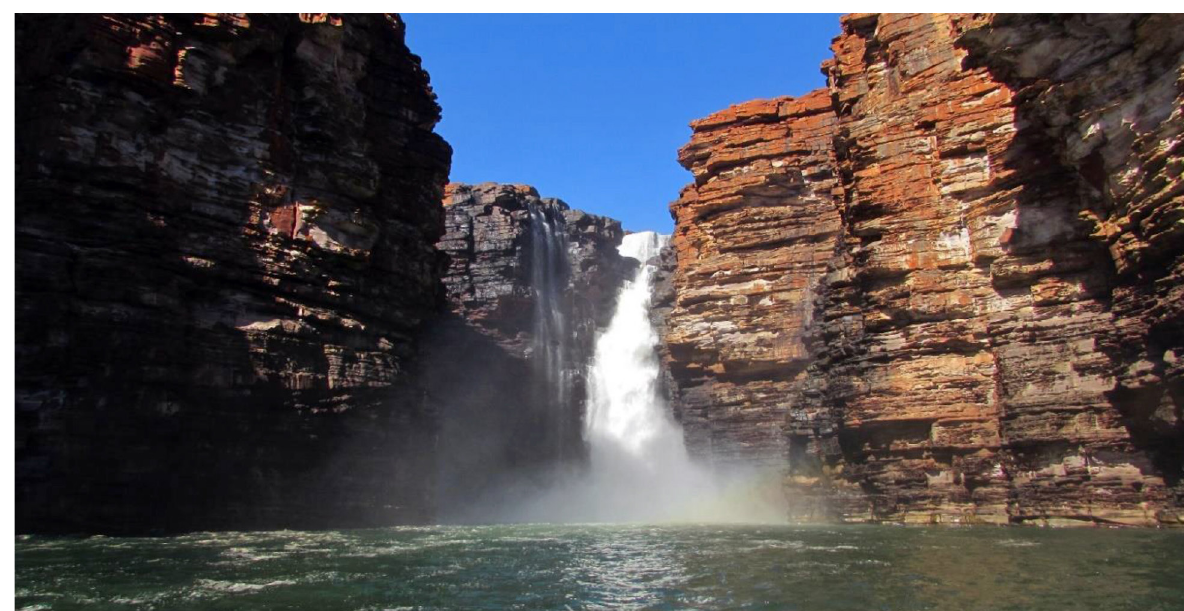
Fig. 5. The King George Falls, Kimberley, Western Australia. Photo: August